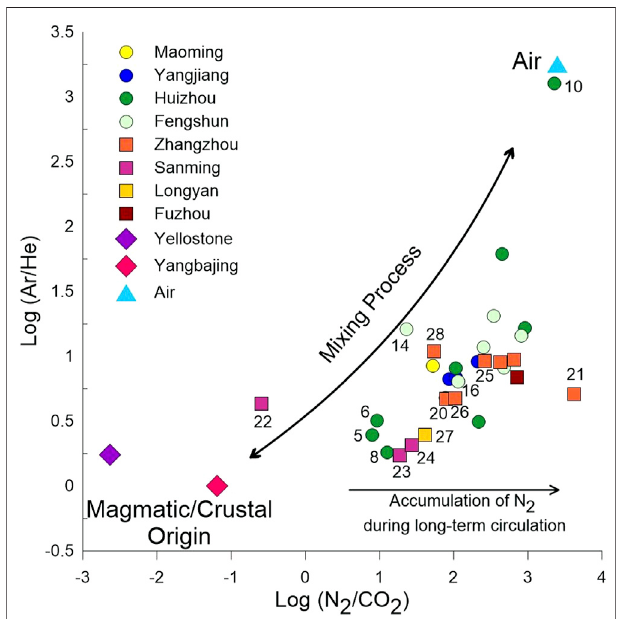
FIGURE2 | Plot ofresults from gas collected from Southeast China with Log(N 2 /CO 2 ) vs. Log(Ar/He). Samples from the Yellowstone geothermal system in the US and Yangbajing geothermal system in China represent magmatic-and crustal-derived geothermal gaseous compositions, respectively (Zhao et al., 2002; Lowenstern et al., 2015). Samples from Guangdong Province are represented by circle symbols, and those from Fujian Province are represented by rectangle symbols.